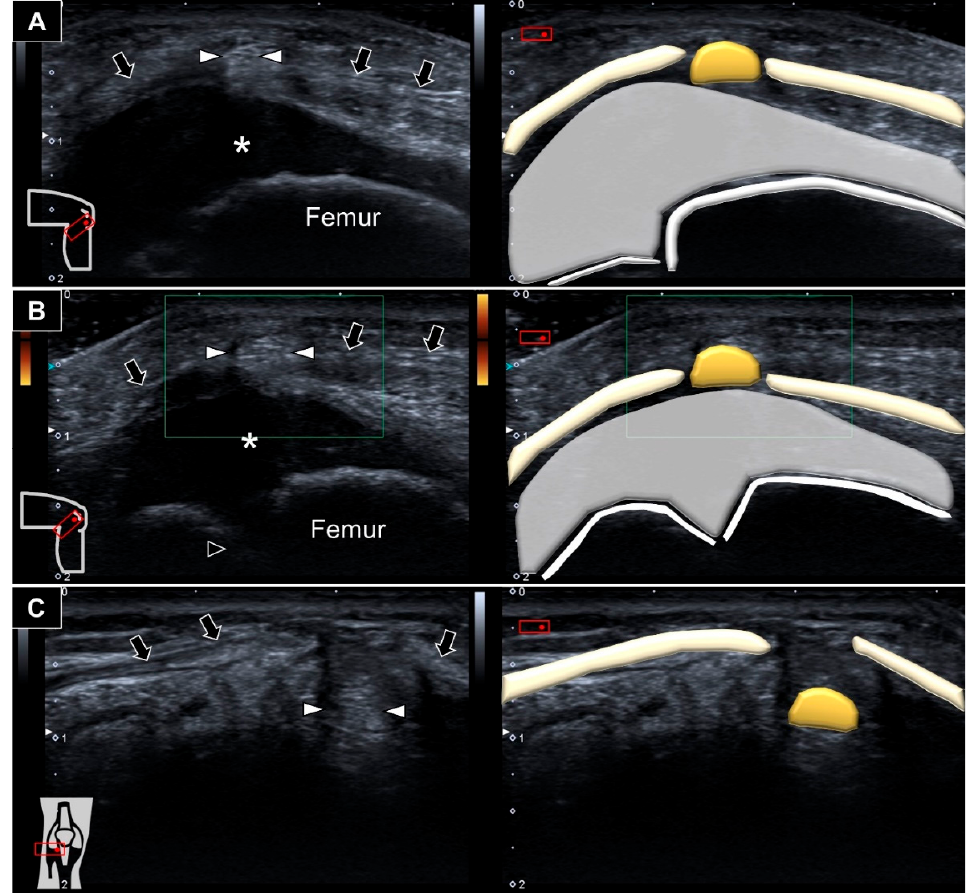
Figure 3. Hyperechoic fat pad (white arrowheads) was seen protruding through a defect in the lateral patellar retinaculum (black arrows) ( A ). There was no vascularity surrounding or inside the protruded fat pad during squatting ( B ). The fat pad was visualized sinking underneath the lateral retinaculum upon knee extension ( C ). *: hyaline cartilage.